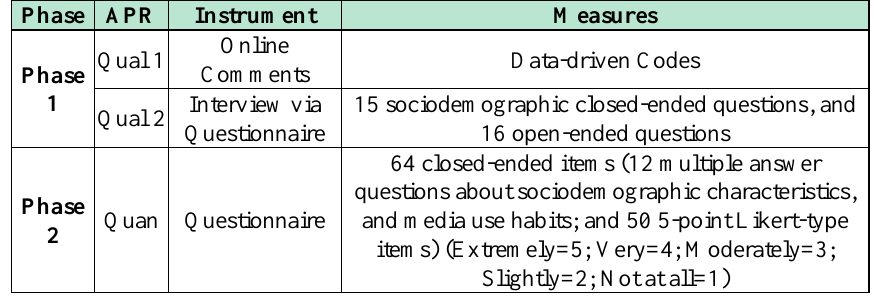
Table 2: Instruments and Measures